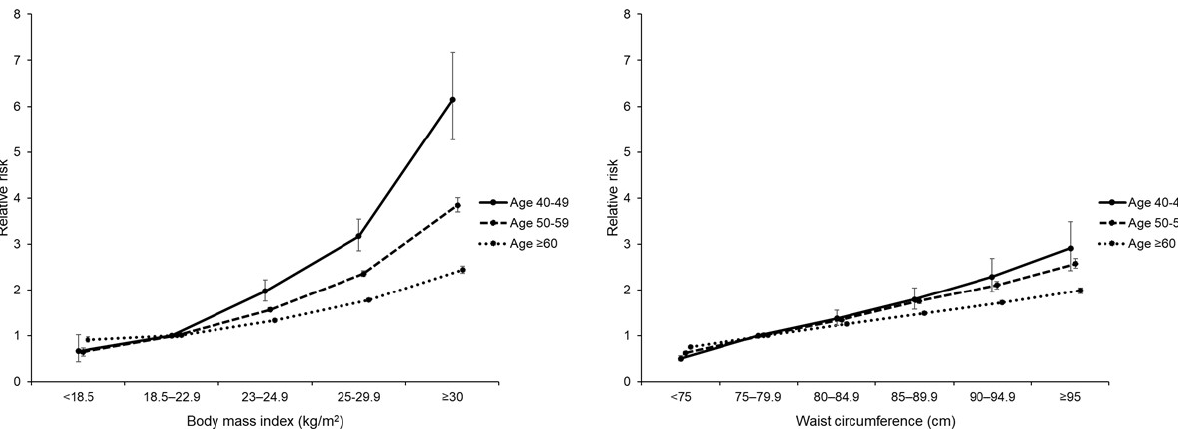
Table 4. Associations between body mass index, waist circumference, and type 2 diabetes risk by menopausal status in 45–54-year-old women.